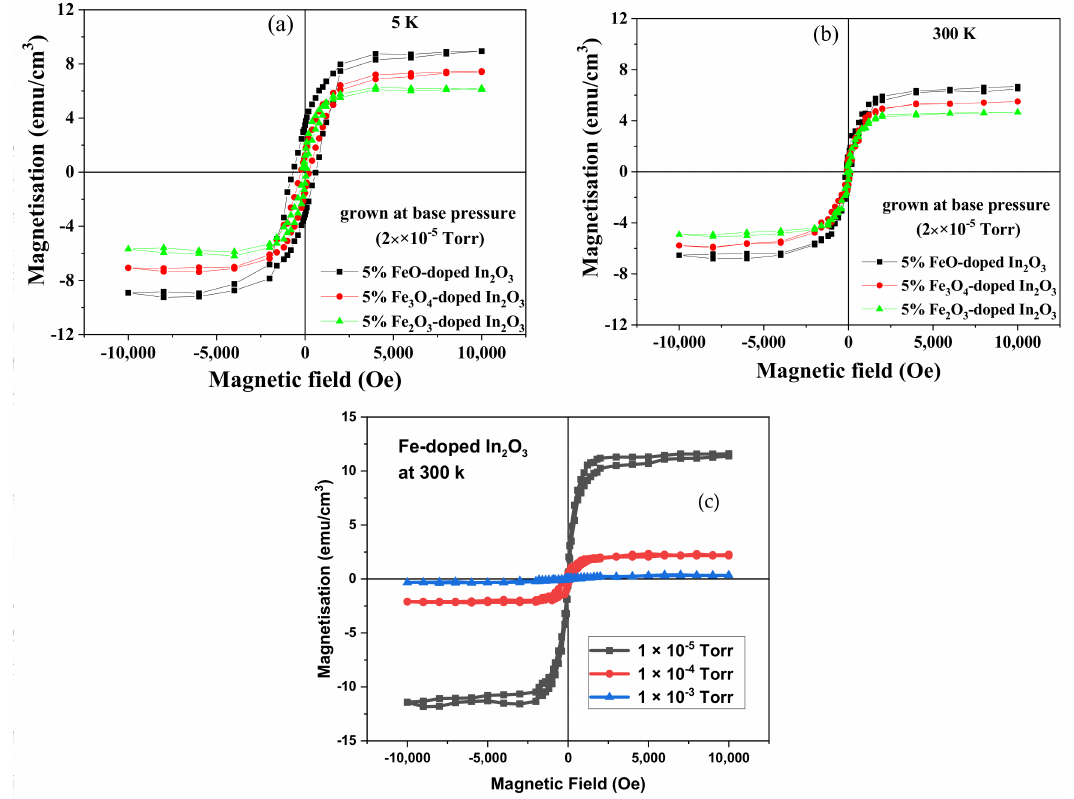
Figure 4. ( a ) and ( b ) are respectively the magnetic hysteresis loops measurements at 5 and 300 K for the Fe-doped In 2 O 3 films from di ff erent oxide precursors at a base pressure of 2 × 10 − 5 Torr, ( c ) shows the room temperature data for films that were made with Fe metal in the precursor. The diamagnetic and paramagnetic terms have been subtracted from all the data shown